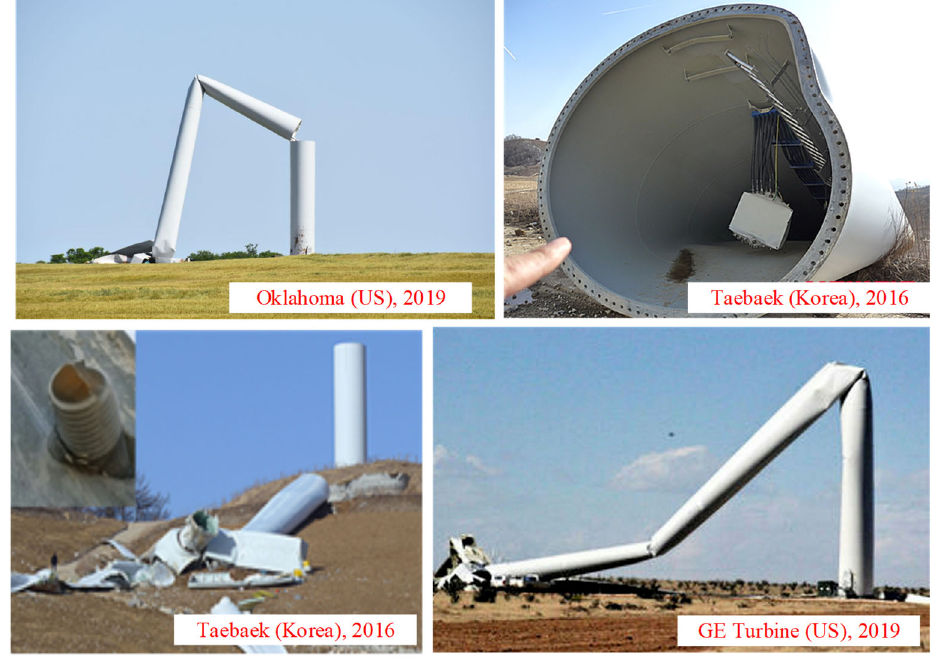
Figure 1. Failure of wind towers.